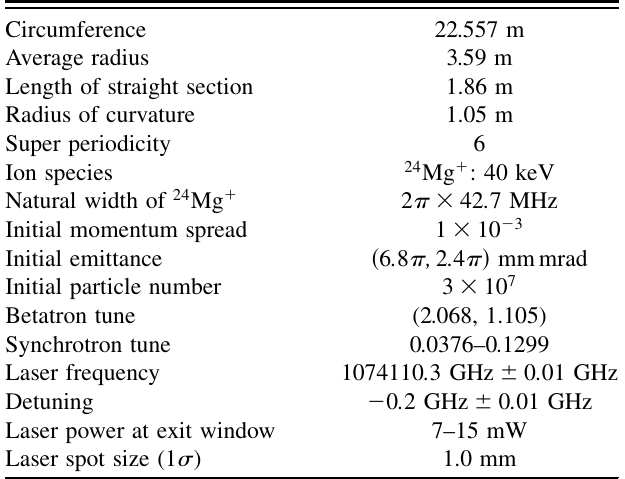
TABLE I. Parameters of laser cooling at S-LSR.